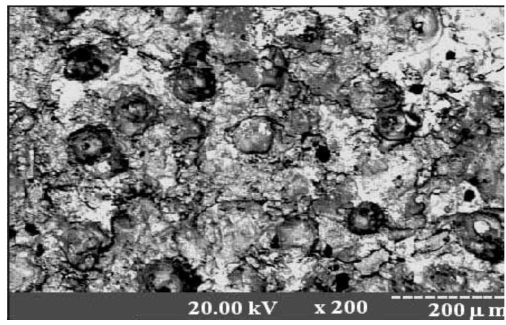
Figure 9. Structure of powder